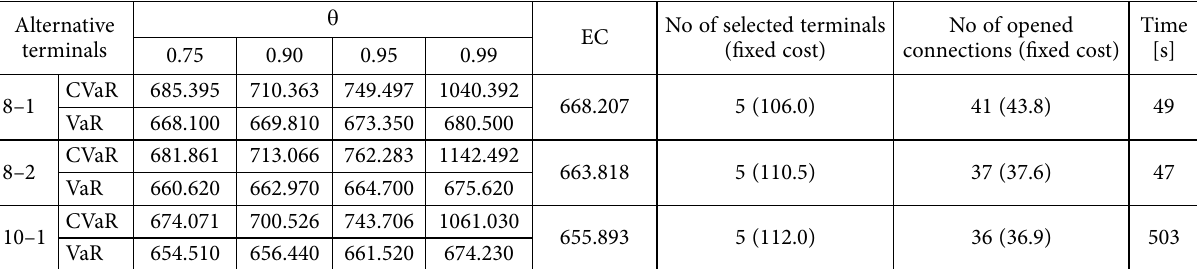
Table 3. Solutions of 2-stage EC model (cost [$10 5 ])